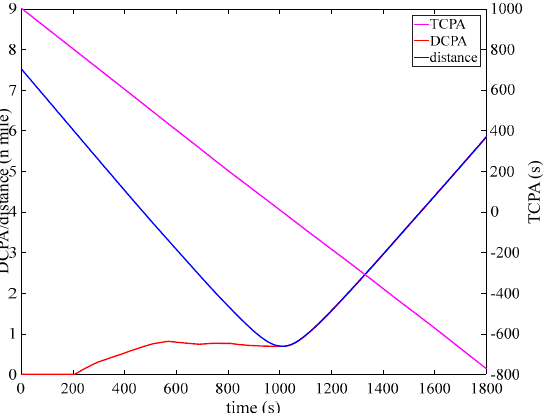
Figure 18. The curve of ship encounter parameters varies with time in head-on situation. The lines and colours in Figure 17 have the same meaning as in Figures 13 and 15.